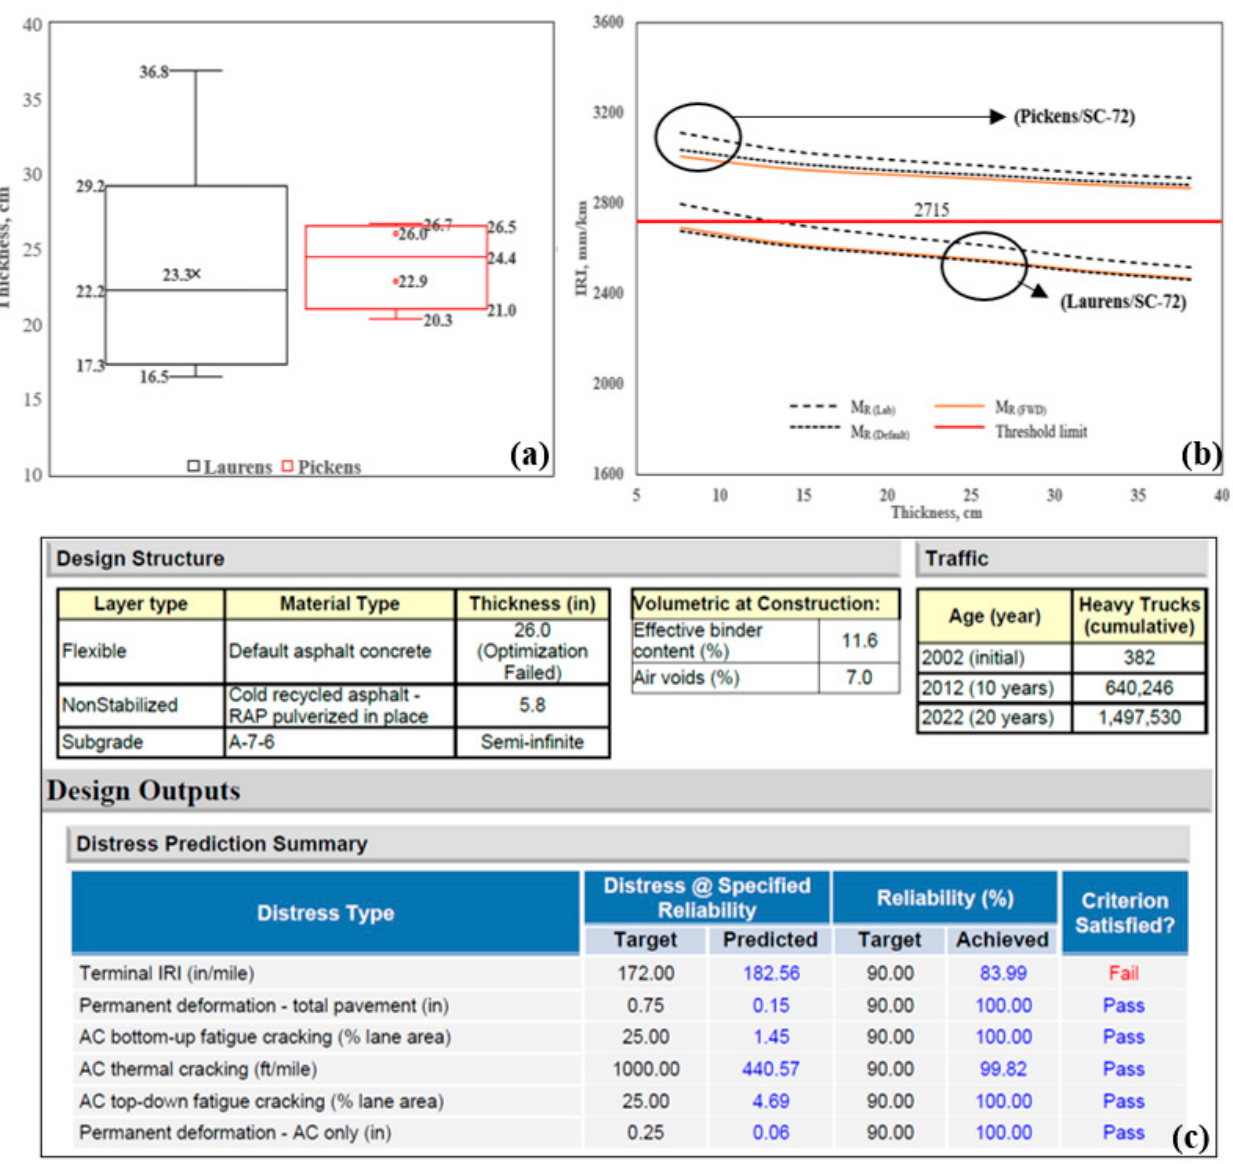
Figure 11. Results for Laurens/SC-72 and Pickens/SC-93: ( a ) Asphalt core thickness profile, ( b ) Sen- sitivity analysis for predicting IRI, and ( c ) Thickness optimization result for Pickens/SC-93 (picture directly taken from AASHTOWare PMED output).